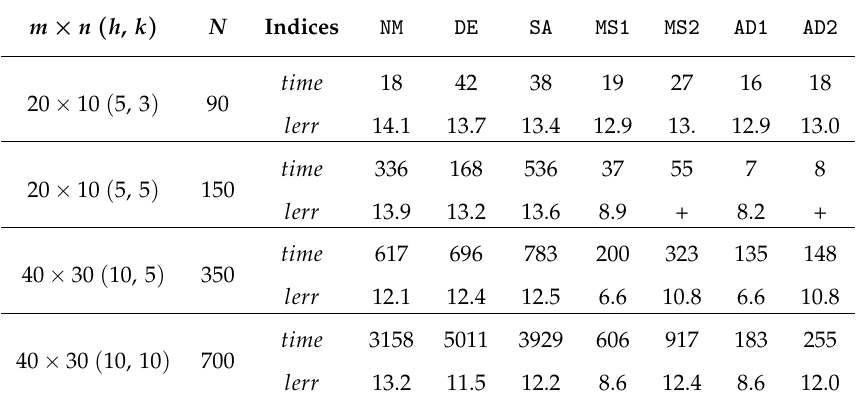
Table 1. Execution times and accuracies for nonsymmetric Nonnegative Matrix Factorization (NMF) problems. m × n ( h , k